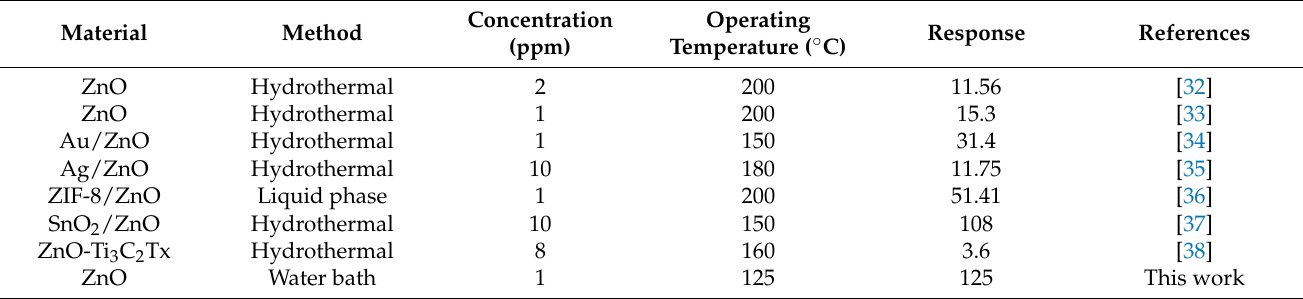
Table 1. Comparison of this present work with reported ZnO − based NO 2